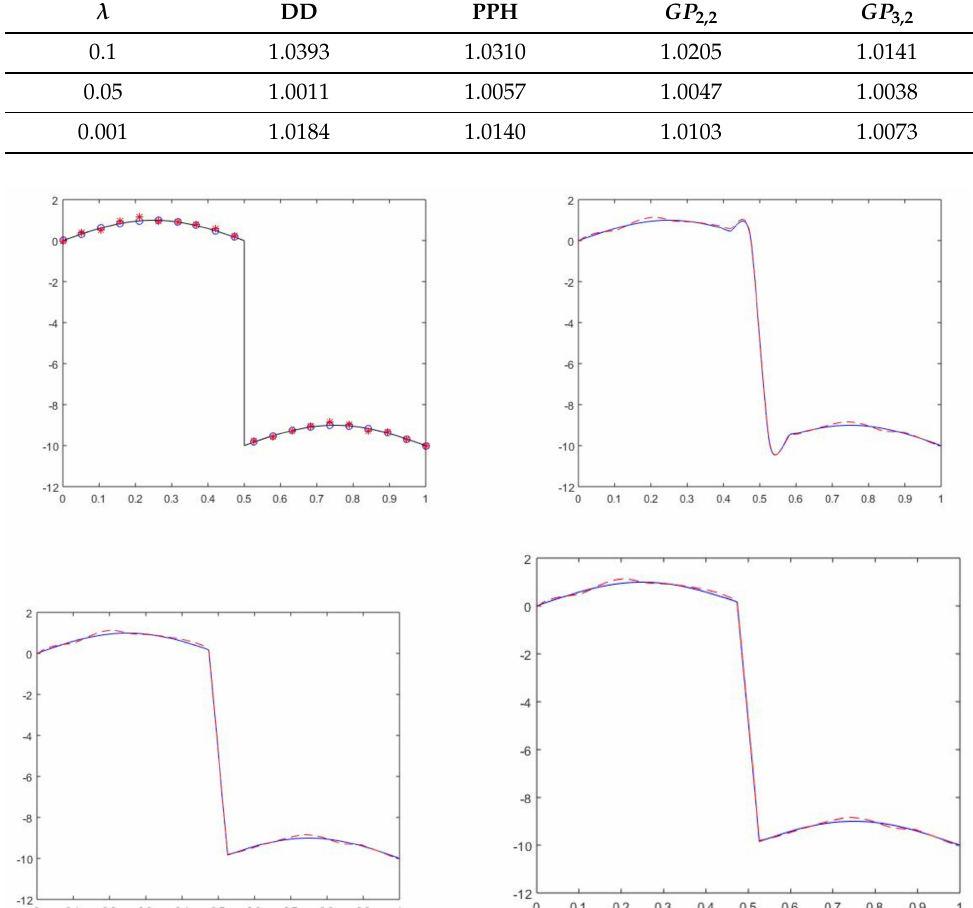
Figure 1. Limit functions obtained with 16 levels of subdivision from the original data f 0 and their perturbed version g 0 with a random perturbation of size λ = 0.1. ( Top-left ): Original function in black—initial data f 0 in blue circles and perturbed data g 0 in red asterisks. ( Top-right ): Subdivision using DD. ( Bottom-left ): Subdivision using PPH. ( Bottom-right ): Subdivision using GP k ,2 with k = 2. The subdivision for the original data is shown with the blue solid line, and that for the perturbed data with the red broken